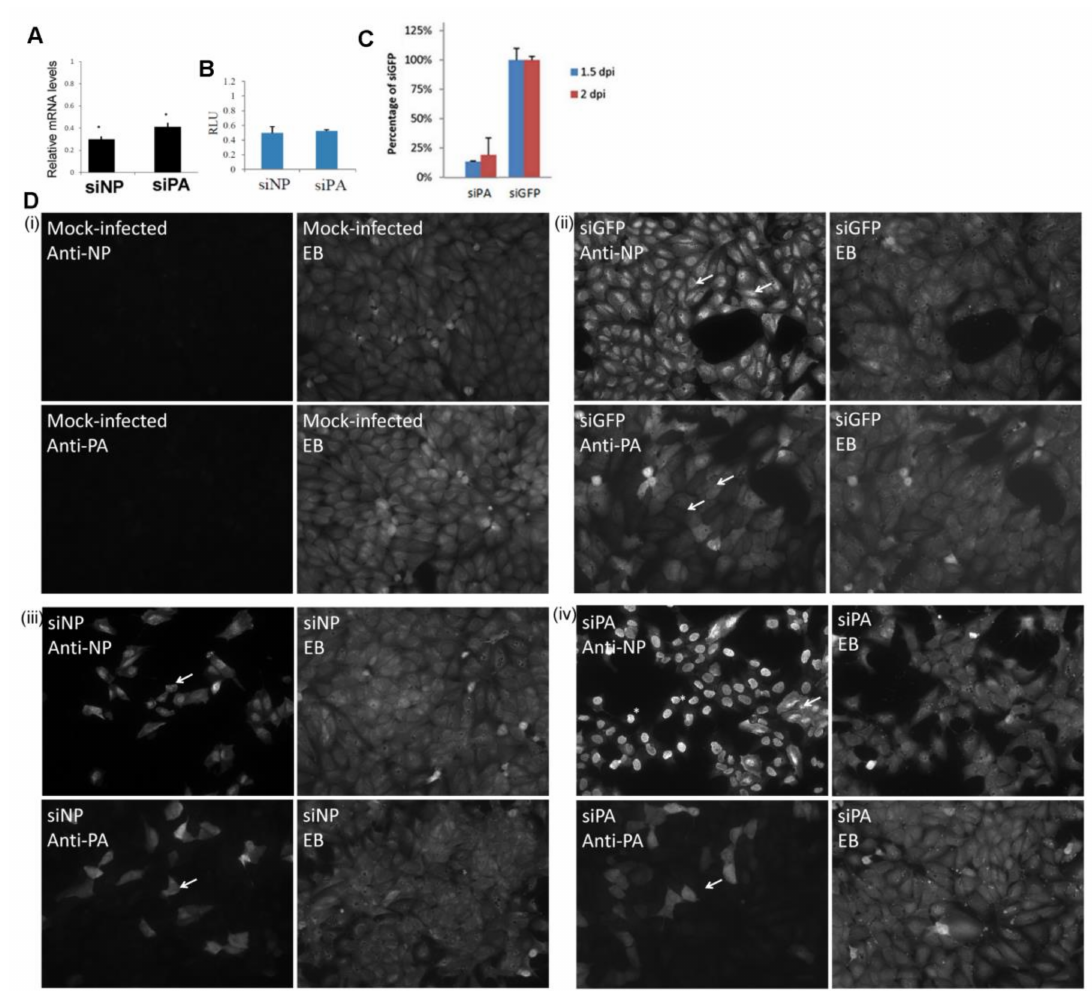
Figure 7. Impaired nuclear export of the RNP occurs after reducing PA protein levels. ( A ) MDCK cells were treated with siNP or siPA and infected with H1N1 / WSN using a multiplicity of infection (MOI) of 5. After 12 h post-infection (hpi) the levels of the NP and PA mRNA in the siNP and siPA levels were determined by qPCR, and the data is presented as the level of NP and PA mRNA compared with that in siGFP-treated cells. * p > 0.05. ( B ) HEKT293 cells were treated with siNP, siPA or siGFP and transfected with the H1N1 / WSN virus pCAGGS / PA, pCAGGS / PB1, pCAGGS / PB2, pCAGGS / NP and the pPol1 / luc. The activity of the polymerase complex was assayed after 4 days, and each assay was performed in triplicate and is expressed as luminescence units (RLU). The RLU values indicated are relative to that of siGFP-treated cells (C) MDCK cells were treated with siPA or siGFP and infected with H1N1 / WSN using an MOI of 0.1. At 1.5 and 2 days-post-infection (dpi) the infectivity in the supernatant was recovered and assayed by plaque assay. Each assay was performed in triplicate. ( D ) Cells were either (i) mock-infected or infected with H1N1 / WSN using a MOI of 5 and treated with (ii) siGFP, (iii) siNP or (iv) siPA. At 16 hpi the cells were stained with anti-NP or anti-PA, and Evans Blues (EB). The cells were imaged using fluorescence microscopy (objective × 20 magnification) and infected cells (white arrows), and nucleus-retained NP (*) are highlighted in